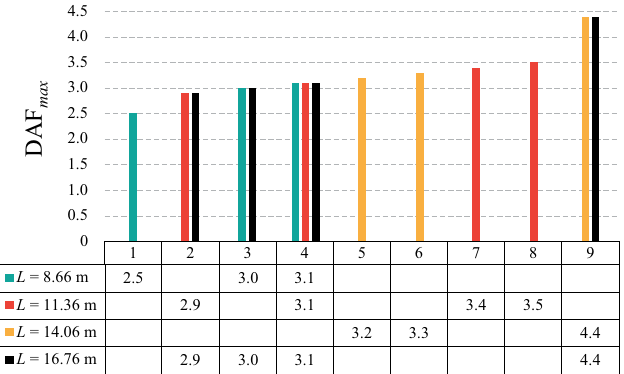
Figure 6. Pre-stressed string reinforced concrete beams with the